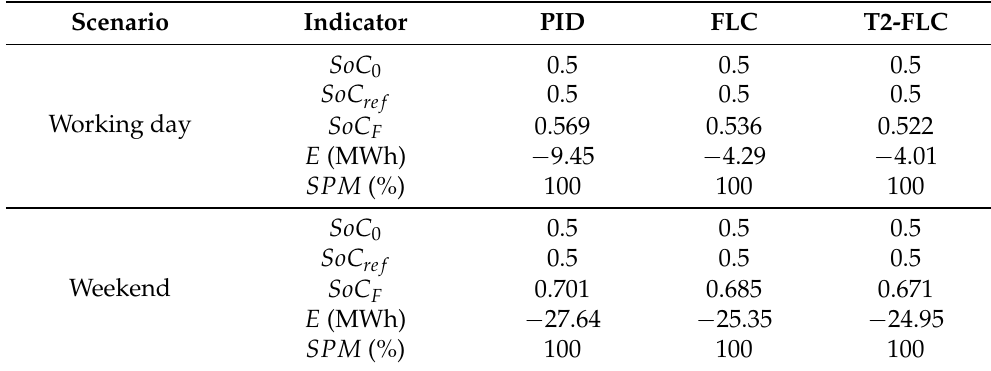
Table 3. Summary results of all proposed